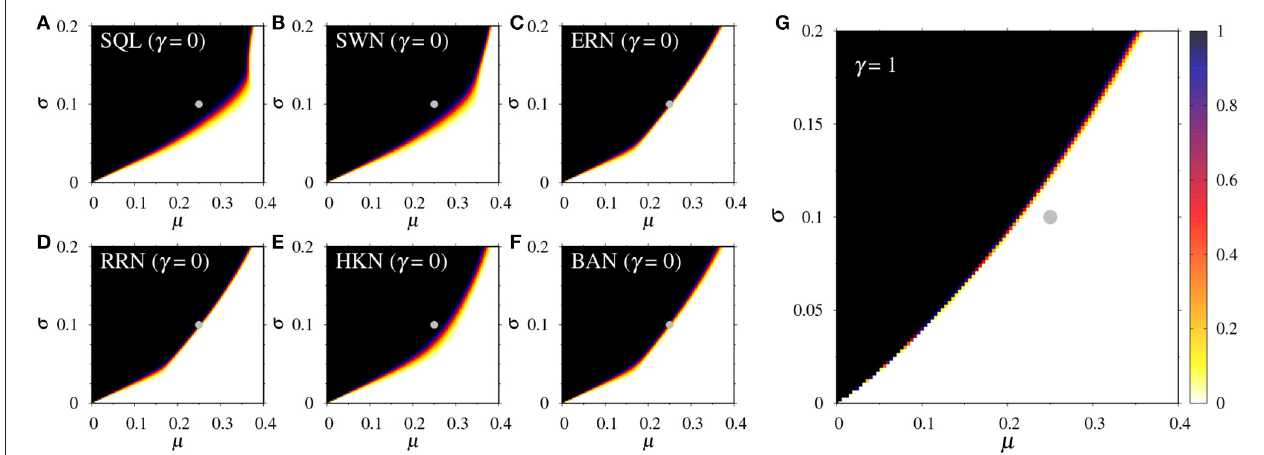
FIGURE 1 | The probability of global cascades as a function of an average µ and a standard deviation σ of the Gaussian probability distribution function of the threshold for the six classes of networks with γ 0 in (A–F) and that if γ 1 in (G) . (The results do not depend on the network structure when γ 1). The rewiring = = = probability P SW 0.05 for SWNs. The gray circle indicates the case of µ 0.25 and σ 0.1. = = = TABLE 1 | Structural properties of the six classes of networks considered in this work: square lattice (SQL) with the Moore neighborhood, small-world network (SWN), Erd ˝ os-Rényi network (ERN), regular random network (RRN), Holme-Kim network (HKN), and Barabási-Albert network (BAN). SQL SWN ERN RRN HKN BAN Degree distribution Regular Poisson Poisson Regular Scale-free Scale-free Presence of hubs No No No No Yes Yes Clustering coefficient Finite Finite 0 0 Finite 0 Average shortest path length Large Small Small Small Ultra-small Ultra-small